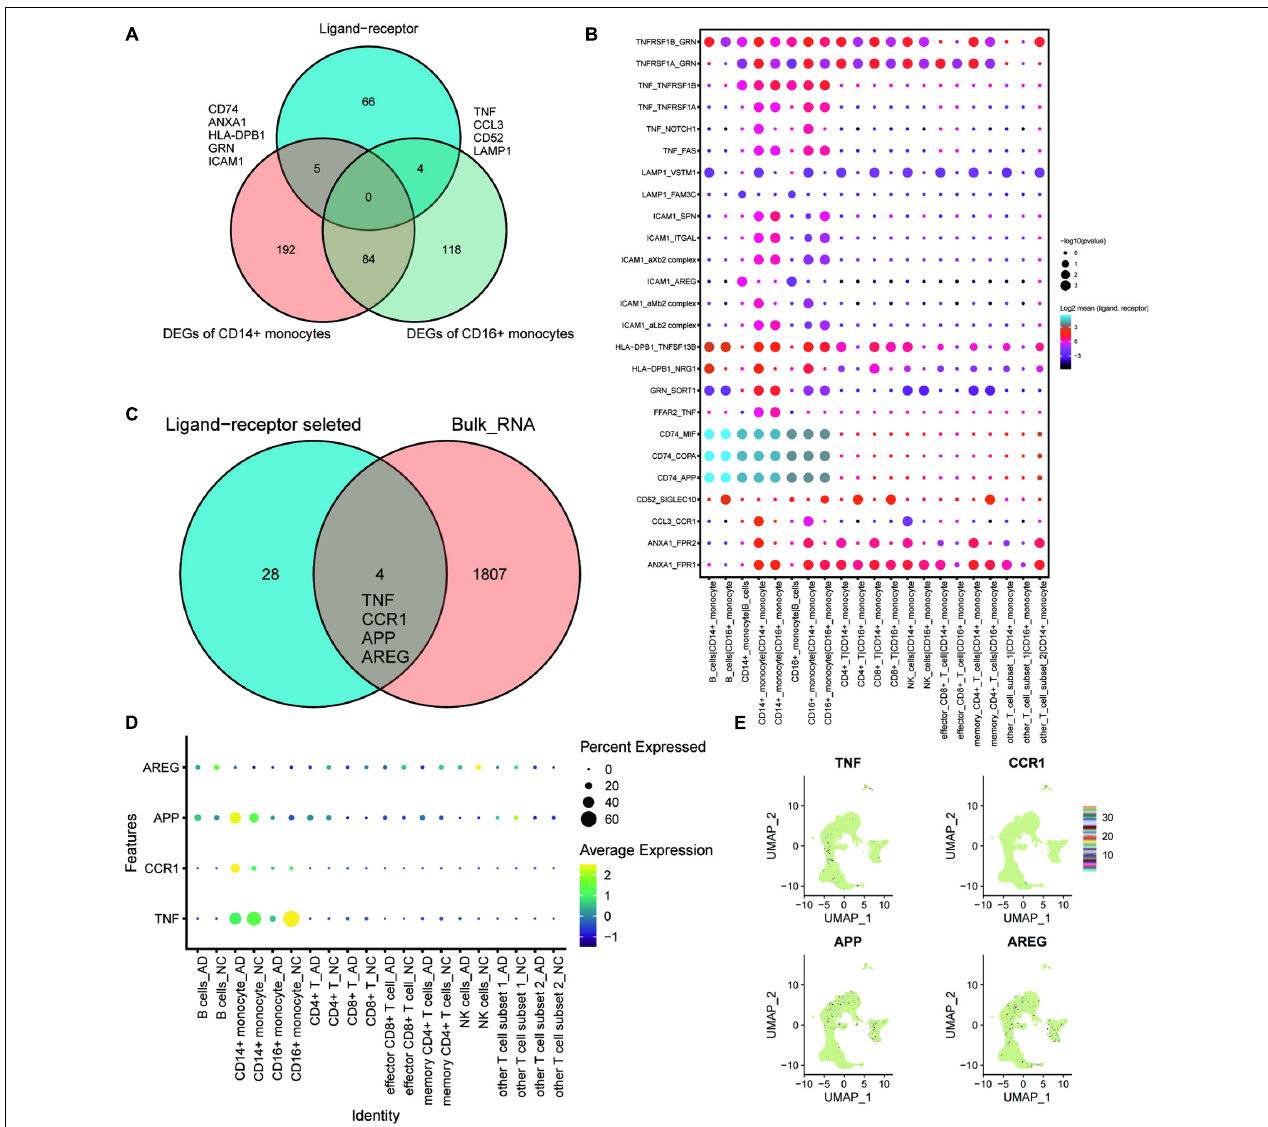
FIGURE 4 | The key ligand-receptor-related genes associated with exercise prescription. (A) Venn diagram analysis identifies CD74, ANXA1, HLA-DPB1, GRN, and ICAM1 as the intersections of DEGs of CD14 + monocytes with intersecting genes of key ligand-receptors, whereas the TNF , CCL3, CD52, and LAMP1 were intersections of DEGs of CD16 + monocytes with key ligand-receptor intersection genes; (B) Pointwise heat map of key ligand-receptor relationship pairs associated with CD74, ANXA1, HLA-DPB1, GRN, ICAM1, TNF , CCL3, CD52, and LAMP1. (C) Wayne plots showing that TNF , CCR1 , APP , and AREG in these selected ligand-receptor relationship pairs were found to be differentially expressed in post-exercise monocytes; (D) Dot heat map demonstrating the differential expression profile of TNF , CCR1 , APP , and AREG genes in the AD and NC groups; (E) Transcriptional features of TNF , CCR1 , APP , and AREG genes in the GSE181279 single cell dataset demonstrated using UMAP